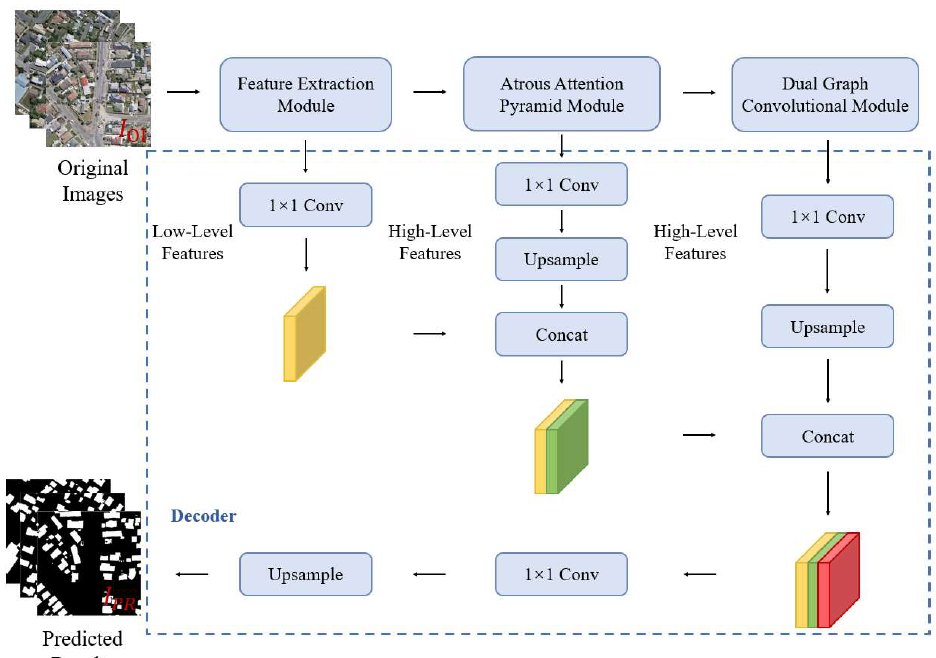
Figure 6. Structure of the decoder module in the BGC-Net.